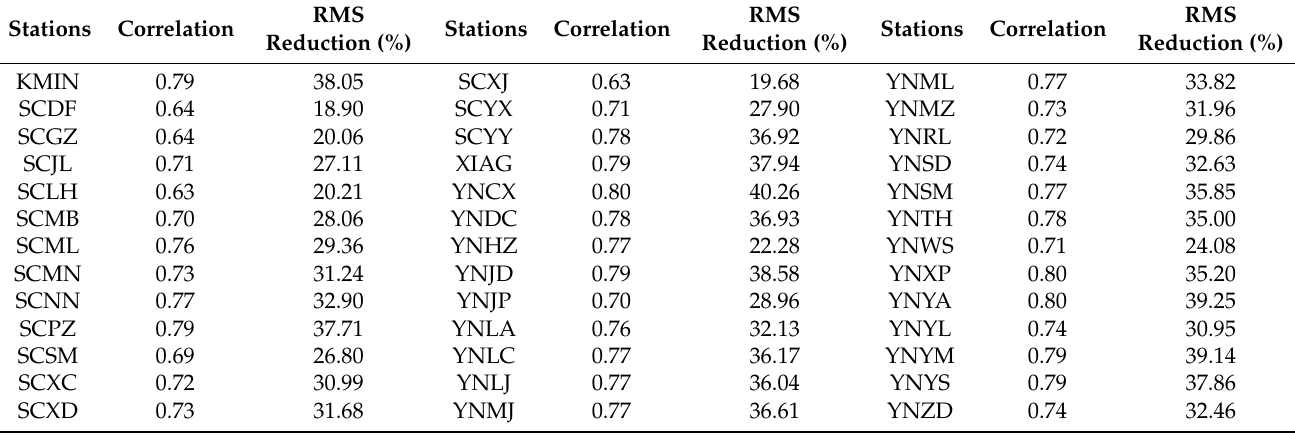
Table 2. Correlation and RMS reduction between CME and EOST_HYDL time series at all stations in the Chuandian